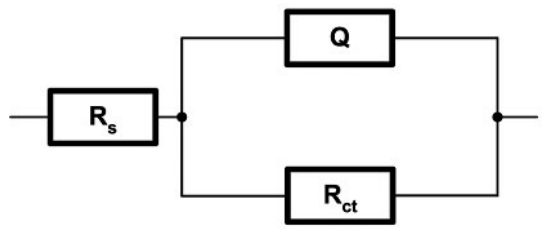
Figure 4. Selected EEC [22].